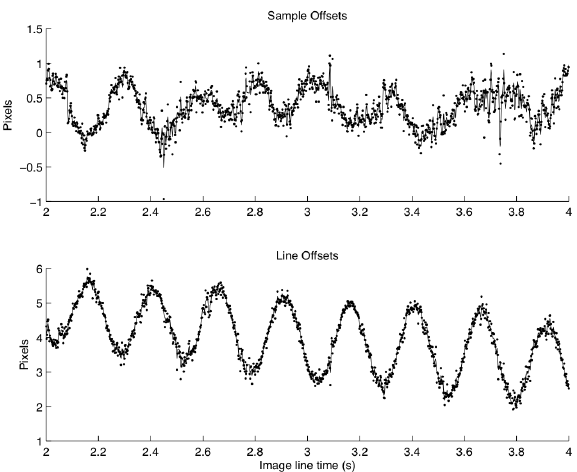
Figure 4. Detail of plot of original pixel offsets (dots) and smoothed data (solid line) from ESP 019988 1750